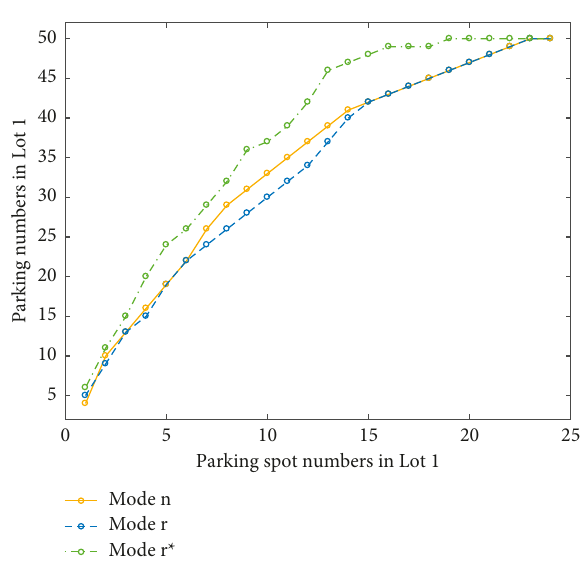
Figure 10: Parking number in lot 1 of the three